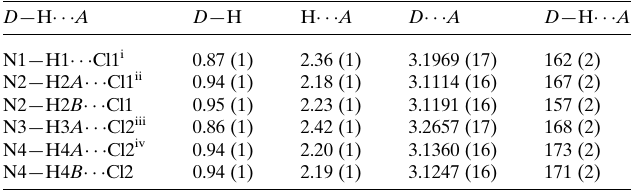
Table 2 Hydrogen-bond geometry (A˚ , (cid:4) ) for ( 3a ).